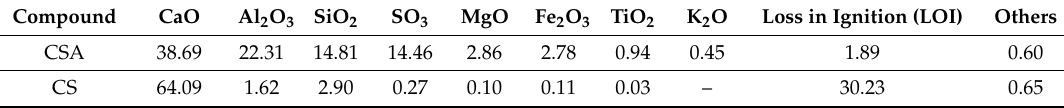
Table 1. Chemical compositions of calcium sulfoaluminate cement (CSA) and carbide slag (CS). Compound CaO